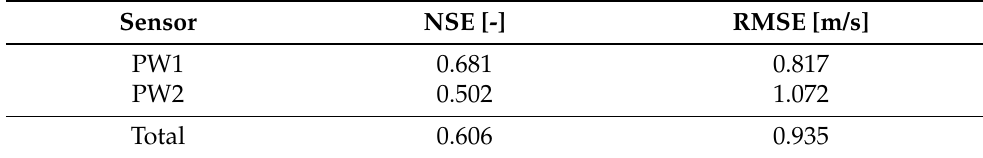
Table 6. Performance indicators of the peak flow velocity u .